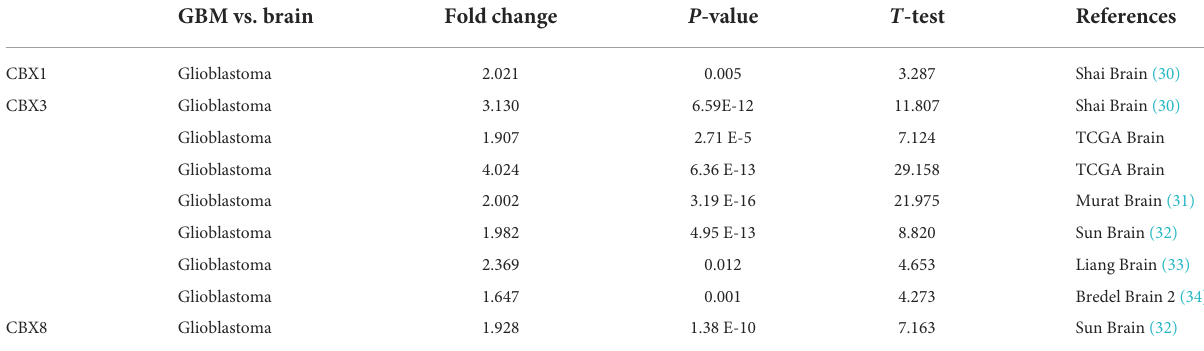
TABLE 1 Changes of CBX family at mRNA and transcription level in GBM by ONCOMINE. GBM vs. brain Fold change P -value T -test